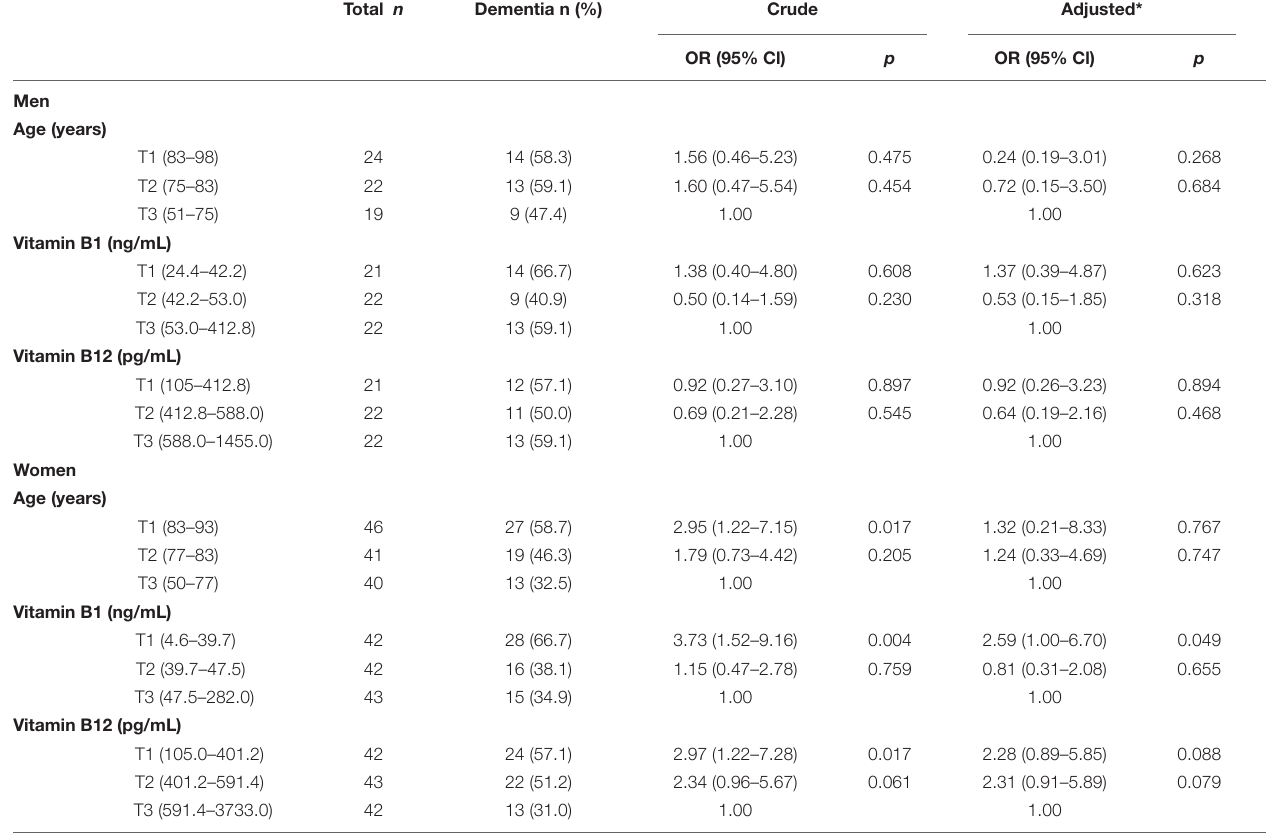
TABLE 5 | Associations of vitamin B1 and vitamin B12 with dementia defined by MMSE ≤ 23 in each sex. Total n Dementia n (%) Crude